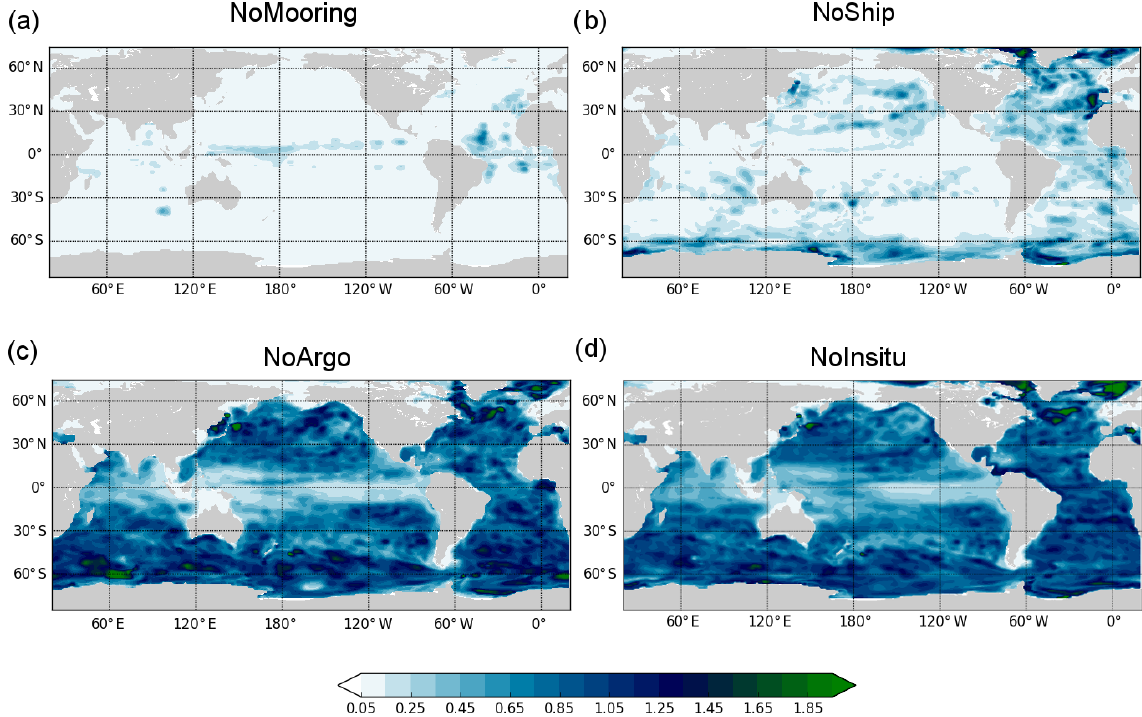
Figure 7. Maps of normalized RMSD of upper 700m column-averaged temperature between the OSE-ALL and (a) NoMooring, (b) NoShip, (c) NoArgo and (d) NoInsitu. Statistics are computed using monthly-mean anomaly data over the 2005–2015 period after removal of the seasonal cycle information and then normalized against the temporal standard deviation of temperature in OSE-ALL over the same period.